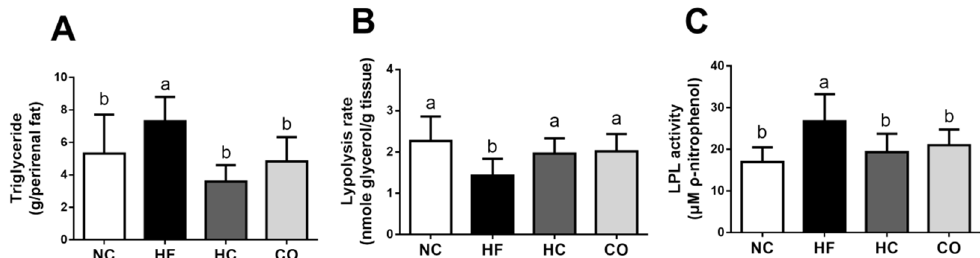
Figure 6. The changes in triglyceride level ( A ), lipolysis rate ( B ), and lipoprotein lipase (LPL) activity ( C ) in the perirenal adipose tissue of rats fed with different experimental diets for 12 weeks. Data are expressed as the mean ± S.D. for each group ( n = 8). Values with different superscript letters (a, b) are significantly different from each other ( p < 0.05). NC: Normal control diet (chow diet). HF: High-fat diet (chow diet + 10% lard). HC: HF diet + 5% high-molecular-weight chitosan. CO: HF diet + 5% chitosan oligosaccharides.